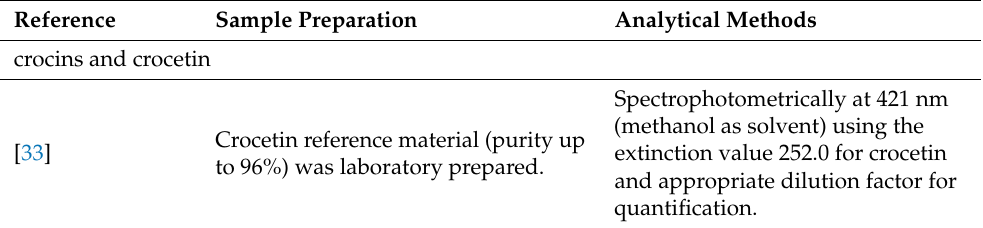
Table 4. En(nano)capsulation approaches for saffron bioactive antioxidants with focus on the char- acteristics of commercial or laboratory prepared products as the starting material, extraction and analytical methods for their isolation and